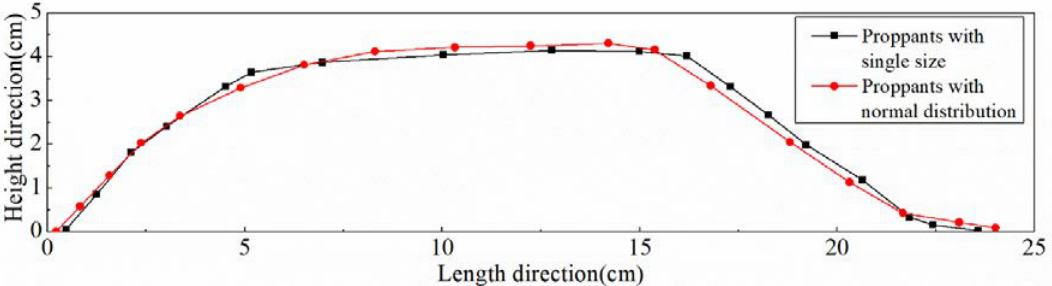
Figure 17. Comparison of the distribution of single-sized proppants and proppants with normal size distribution (t = 2 s).